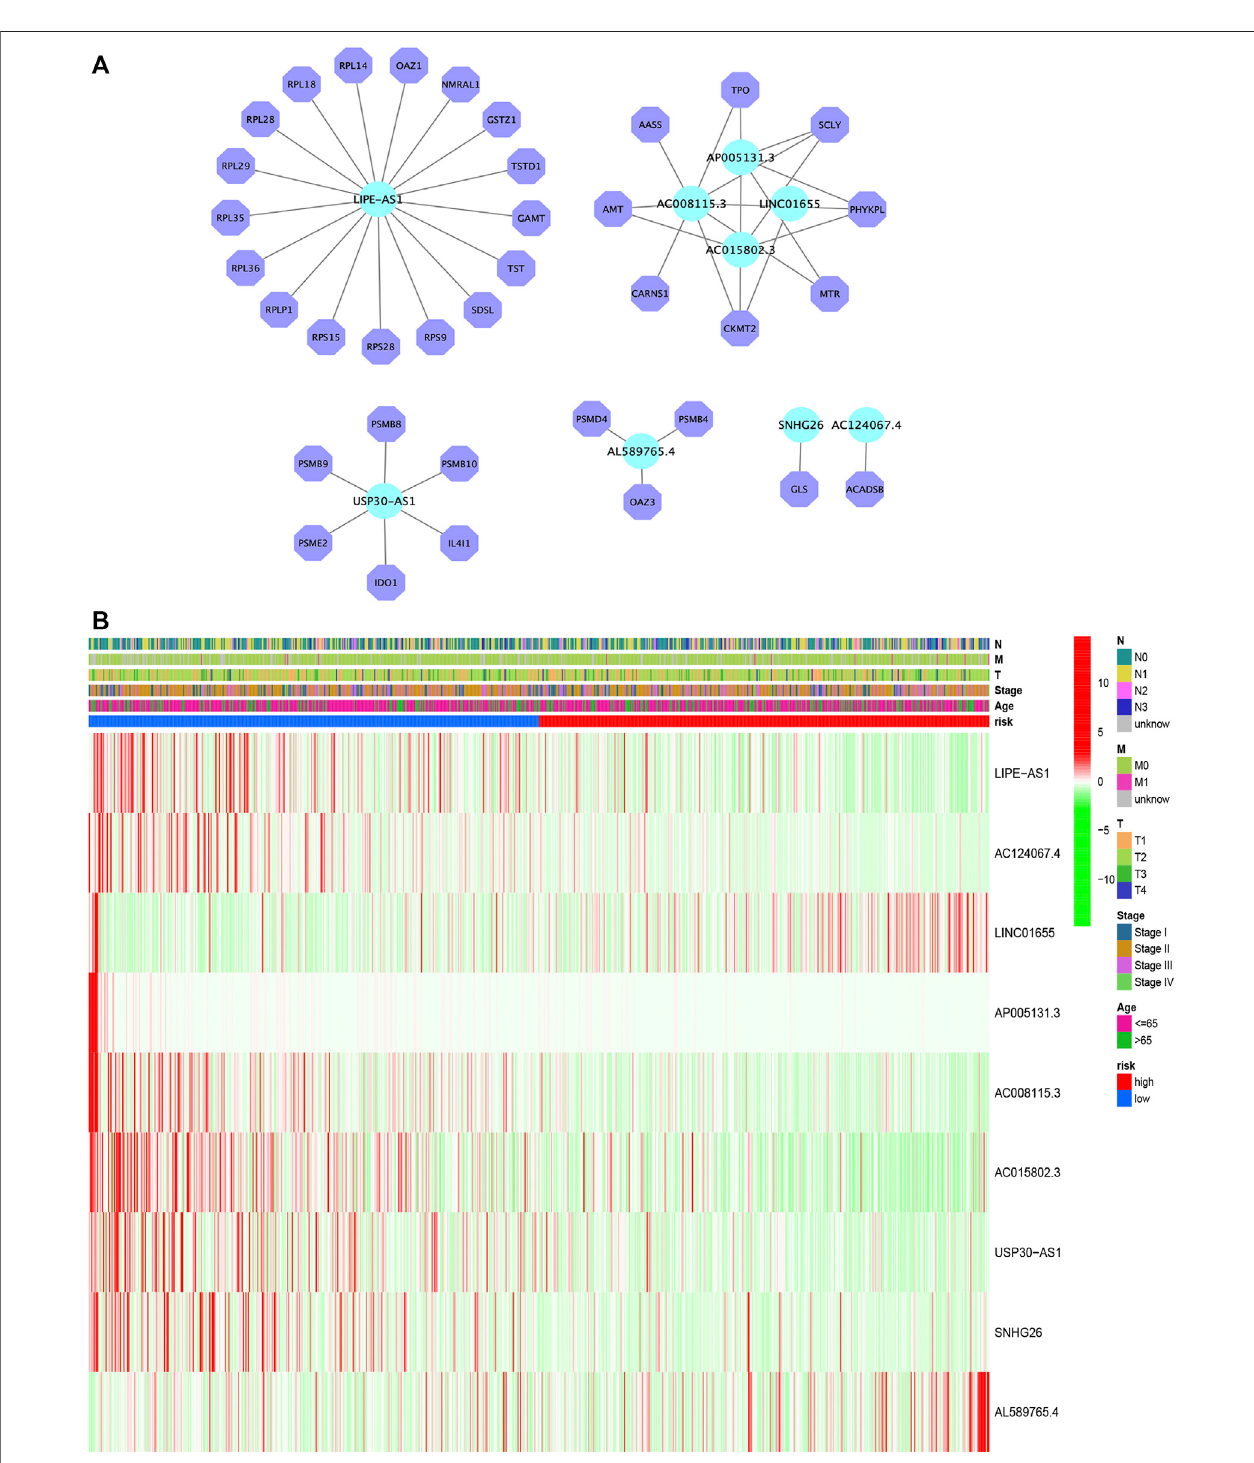
FIGURE 4 | Construction of the mRNA – lncRNA regulatory network (A) . Heatmap of the clinicopathological manifestations and AAM-related lncRNA prognostic signature (B) .